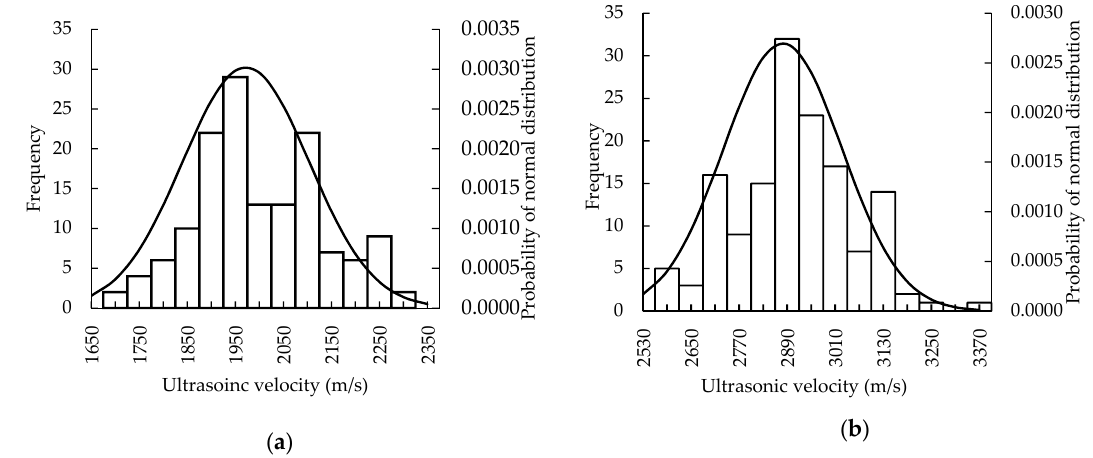
Figure 7. Results of statistical analysis for ultrasonic velocities: ( a ) test on July 24; ( b ) test on November 5.